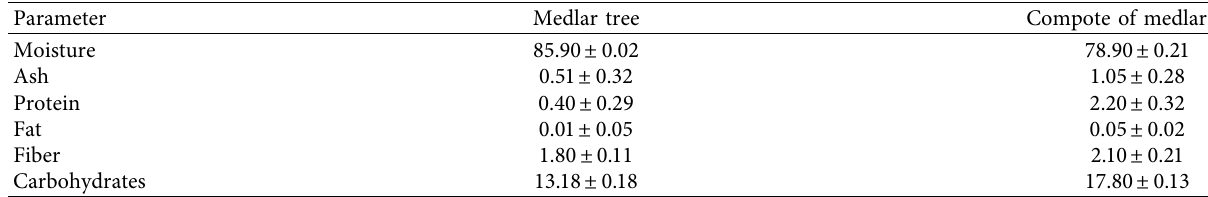
Table 4: Proximal composition of loquat ( Mespilus germ´anica L.) and compote from loquat pulp with addition of 0.20% agar from Chondracanthus chamissoi .